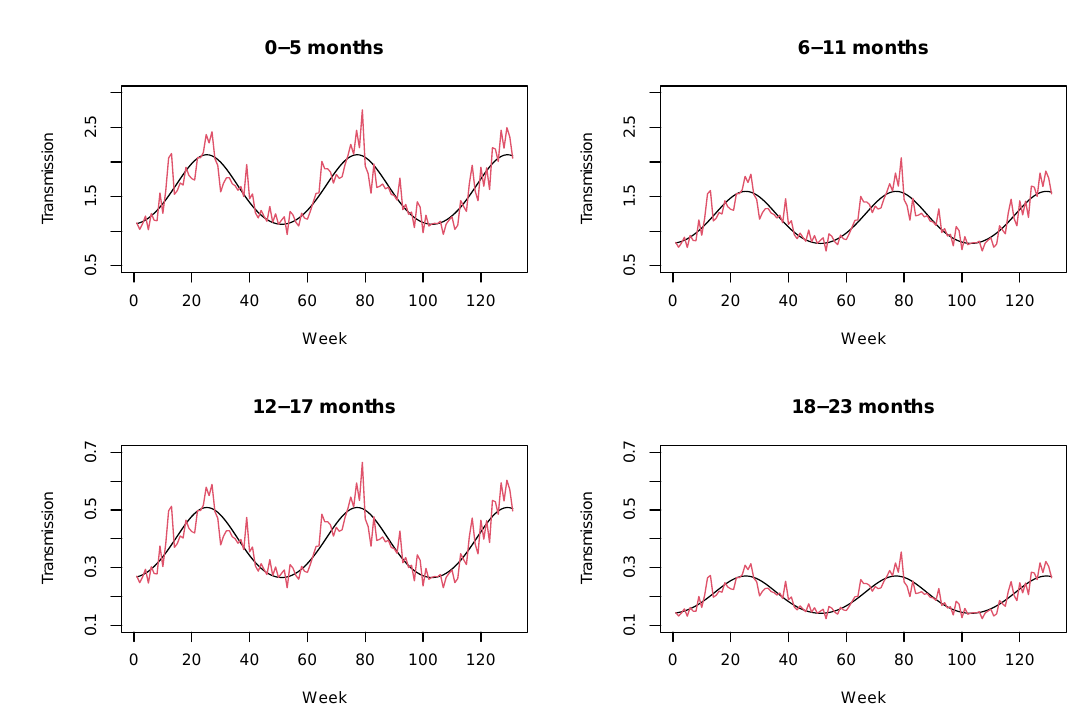
Figure 3. Estimated autoregressive parameter (red line) together with its seasonal component (black